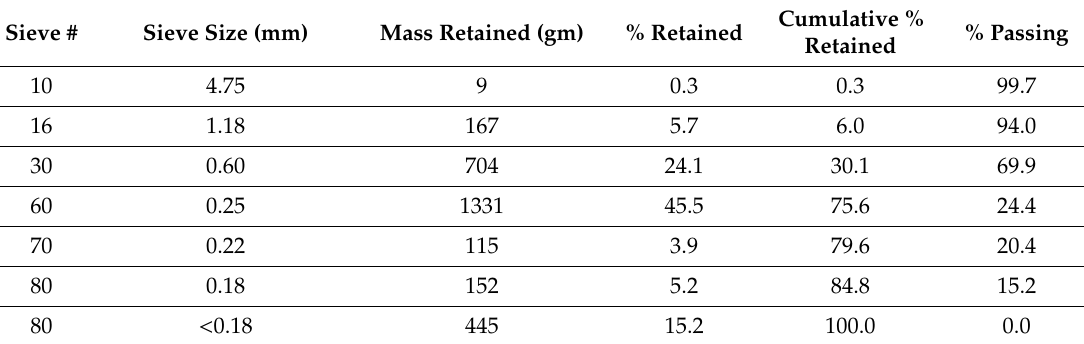
Table 1. Sieve analysis for Sakrete © play